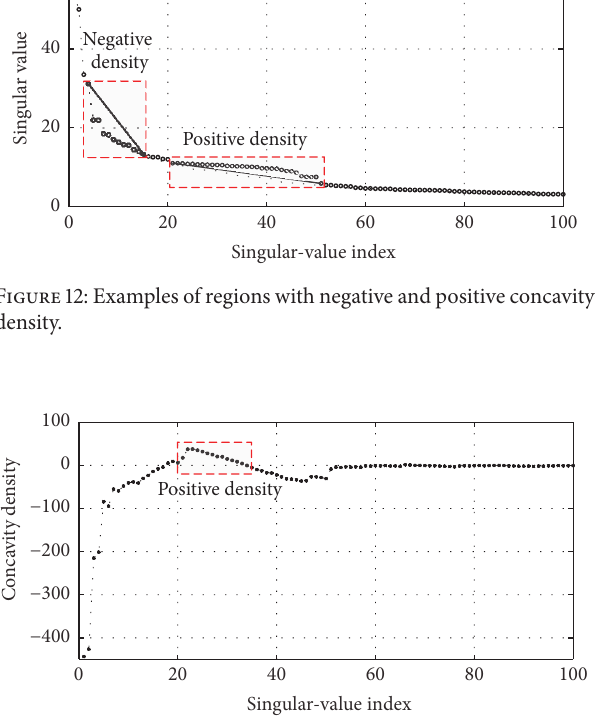
Figure 13: Concavity density set {𝐷 1,31 , 𝐷 2,32 ,...,𝐷 100,130 } . Notice that there is a strong relationship between the region of positive density and the indices of modified singular values.